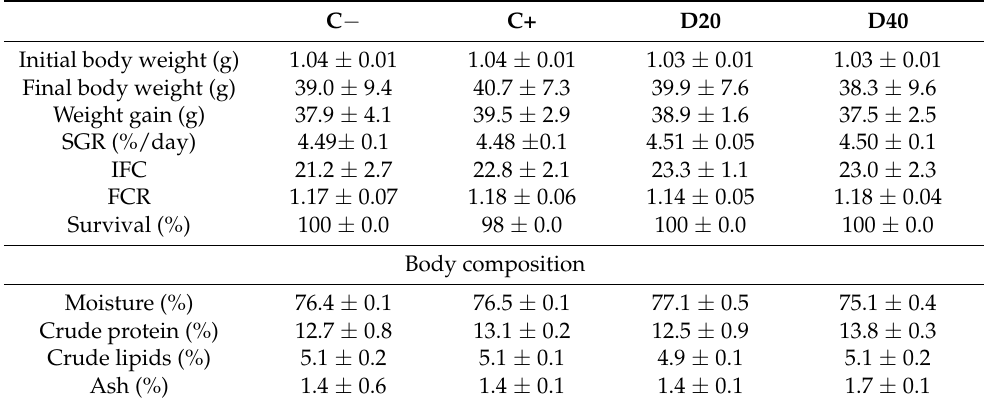
Table 2. Growth performance and body composition of Nile tilapia ( O. niloticus ) fed an agavin- supplemented experimental diet after 80 days under low-density conditions.